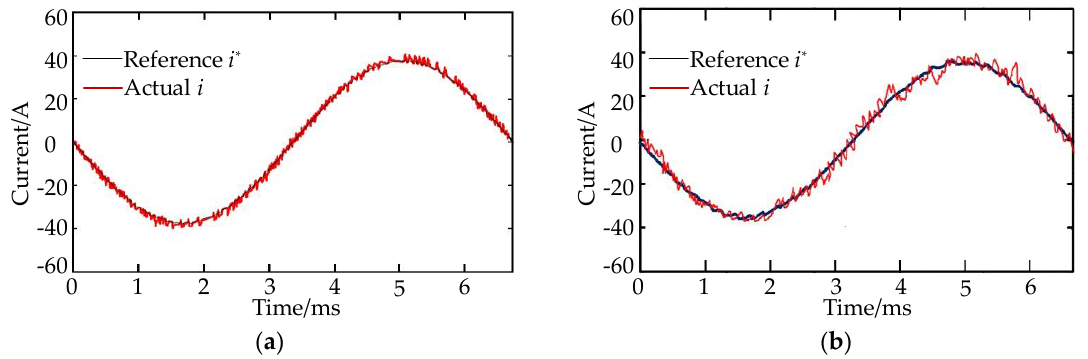
Figure 14. Vector waveform of generator’s output current. ( a ) Proposed strategy; ( b ) Traditional SVM strategy.